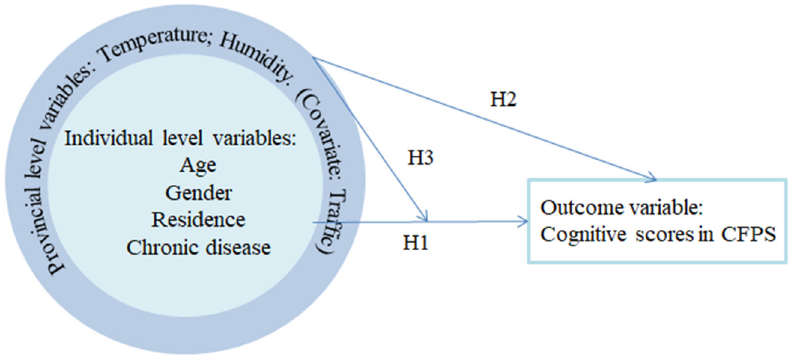
Figure 1. The proposed multi-level model.